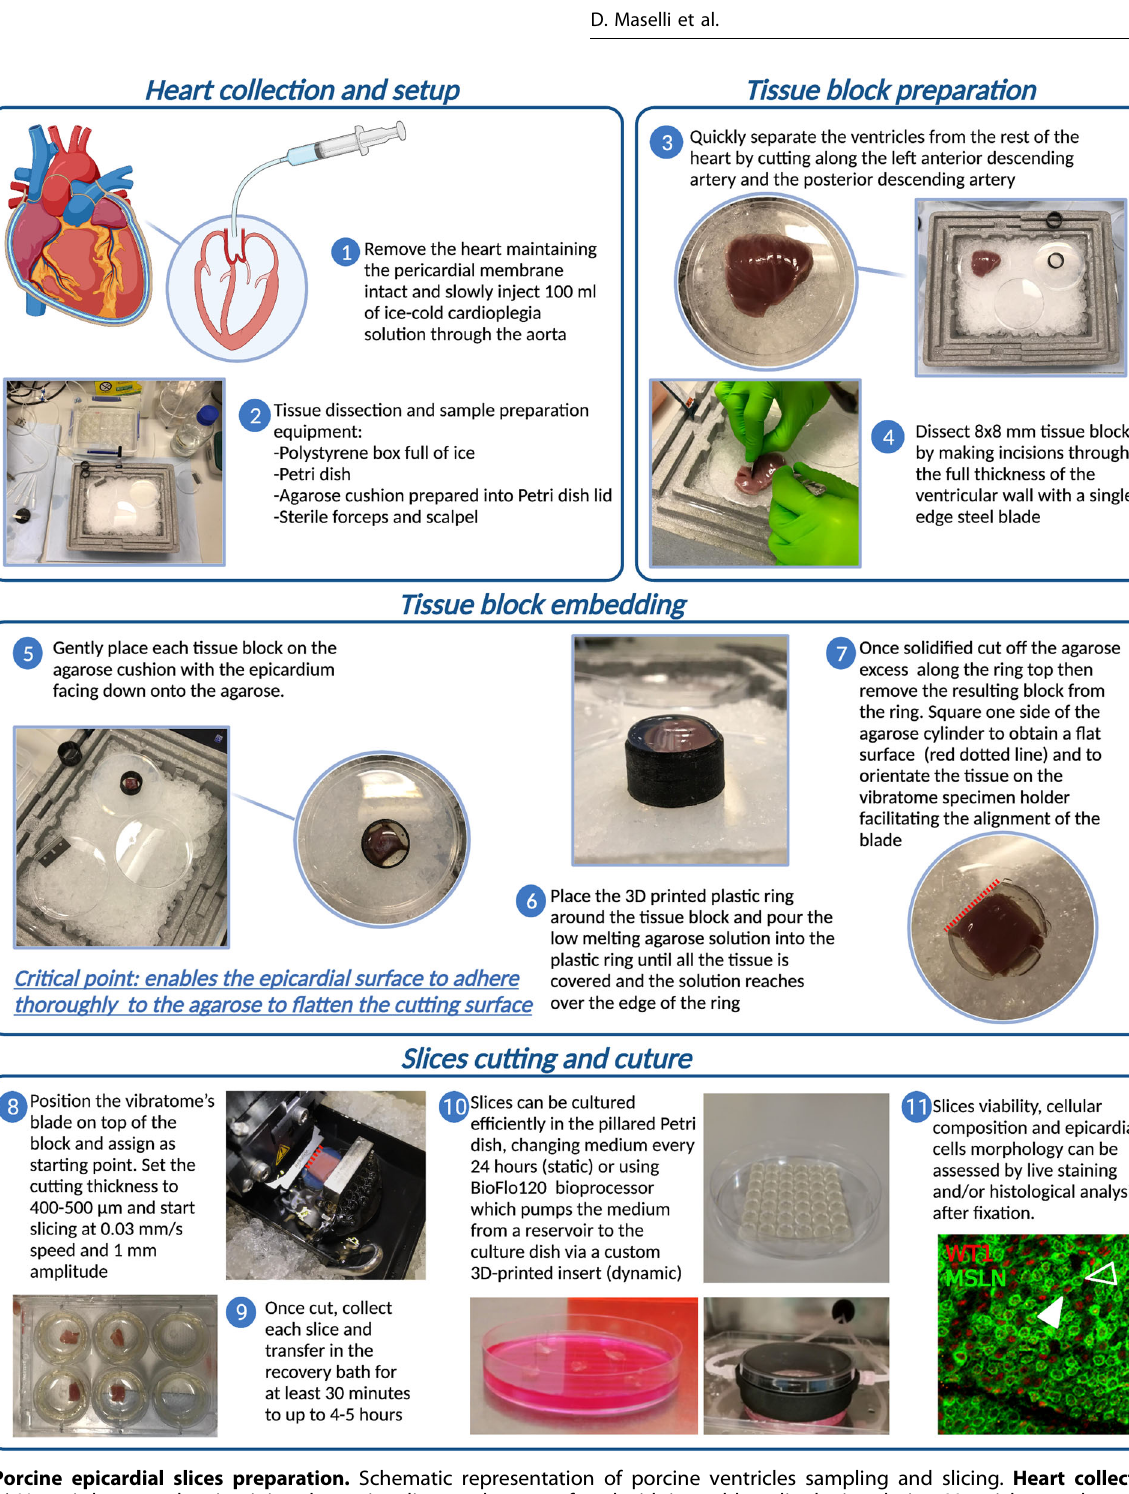
Fig. 1 Porcine epicardial slices preparation. Schematic representation of porcine ventricles sampling and slicing. Heart collection and setup: (1) Heart is harvested maintaining the pericardium and retroperfused with ice-cold cardioplegia solution. Ventricles are then separated from the heart avoiding touching the epicardium, to prevent damage. (2) Embedding area must be set up prior to tissue slicing to allow all components to cool down to ice-cold temperature. Tissue block preparation: (3) Cardiac tissue is placed on the ice-cold Petri dish and (4) blocks of tissue 8 mm ×8 mm are dissected with a single edge steel blade. Tissue block embedding: (5) The epicardial side of the slice is fl attened onto a cold agarose surface and placed in the middle of a custom-made 3D printed ring. 5 – 8 ml of 30 – 37 °C low melting agarose is poured to embed the tissue block. (6) Once solidi fi ed, the block is removed from the ring and (7) squared on one side to allow a better alignment with the vibratome ’ s blade (red dashed line). Slice cutting and culture : (8) Embedded tissue blocks are oriented along the squared side and glued to the vibratome specimen holder. The blade is aligned to the epicardial surface and 400 – 500 µm thick slices are cut using a high precision vibratome. (9) Slices are allowed to recover for at least 30 min in a recovery bath. (10) Epicardial slices are cultured epicardium- up on 8-mm-high pillars cast at the bottom of a Petri dish. (11) En face immunohistochemistry of WT1 (red) and mesothelin (MSLN, green) shows the presence of a continuous epicardial layer, characterized by typical morphology and marker expression (WT1 + cells indicated with full arrowhead, WT1 − MSLN + cells indicated with empty arrowhead). This fi gure was created using